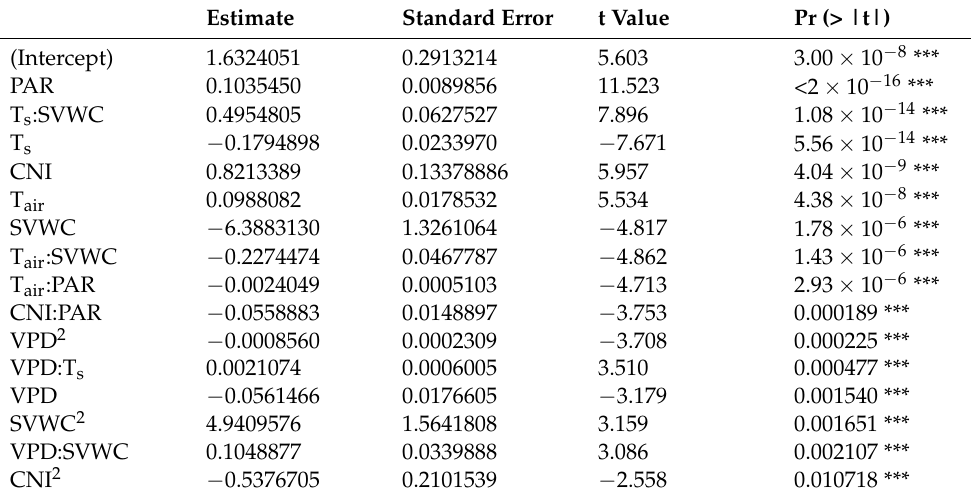
Table A5. Results of the stepwise multi-linear regression model on the significant environmental variables that influenced the normalized gross primary productivity (GPP norm ) at the beech forest site in Štítná (CZ-Stn). CNI: clearness index; PAR: photosynthetic available radiation; T air : air temperature; T s : soil temperature; SVWC: the soil volumetric water content; and VPD: vapour pressure